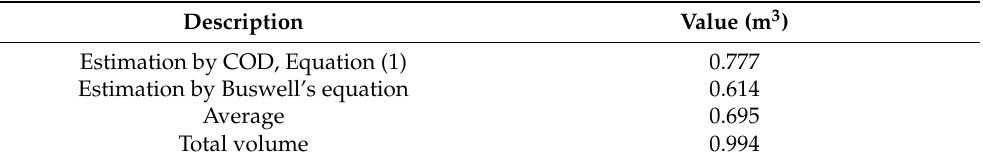
Table 3. Bio-reactor sizing